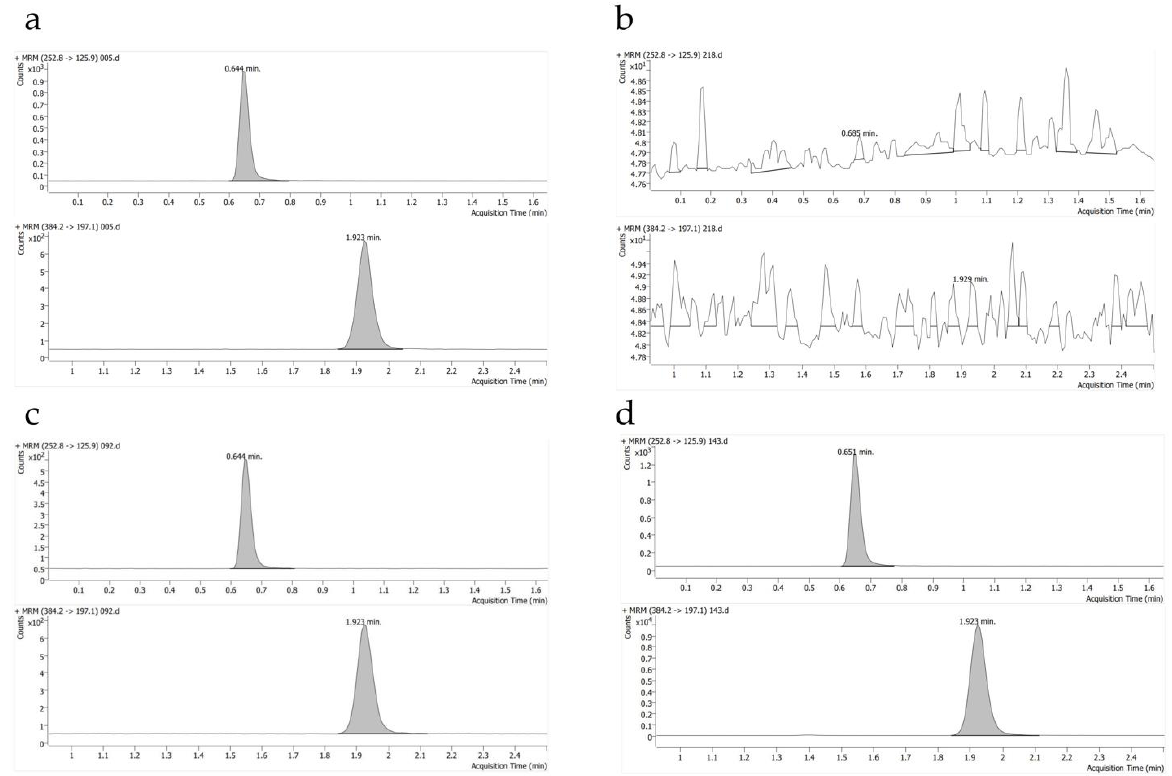
Figure 2. The representative UHPLC – MS/MS chromatograms of thiacloprid and tolfenpyrad. ( a ) solvent standard (0.005 mg/L); ( b ) dry tea blank sample; ( c ) dry tea spiked sample (0.05 mg/kg); ( d ) dry tea sample of Anhui province collected on 0 d (2 h).